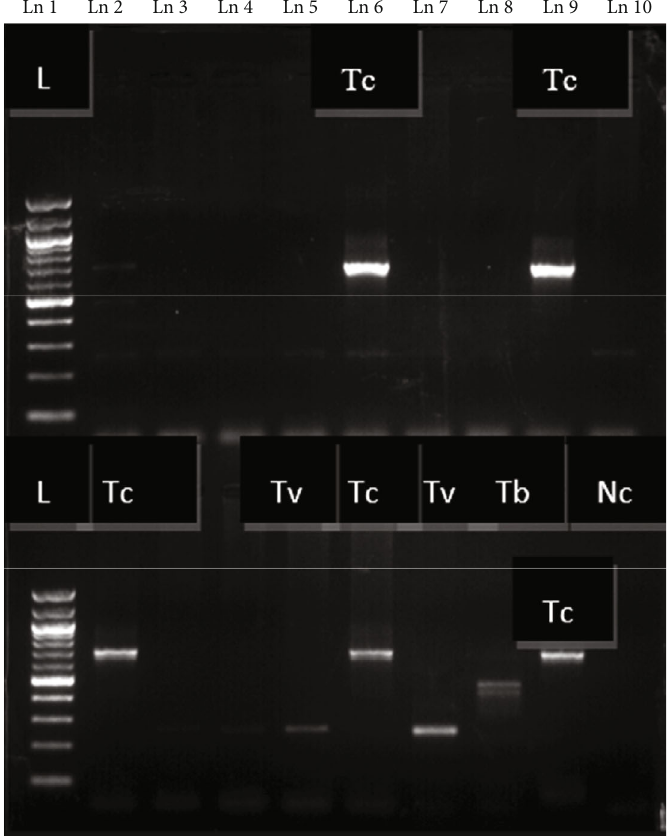
Figure 2: ITS1 PCR bands from one region. Ln stands for lane. Row 1: Ln 1, 100bp ladder; Ln 2, weak mixed infection; Ln 3, 4, 5, 10, weak T. vivax ; Ln 6, T. congolense and weak T. vivax ; Ln 9, T. congolense . Row 2: Ln 1, ladder; Ln 2 and 6, T. congolense ; Ln 3, 4, 5, weak T. vivax ; Ln 7, 8, 9, positive controls; T. v , T. b , T. c , Ln 10, negative